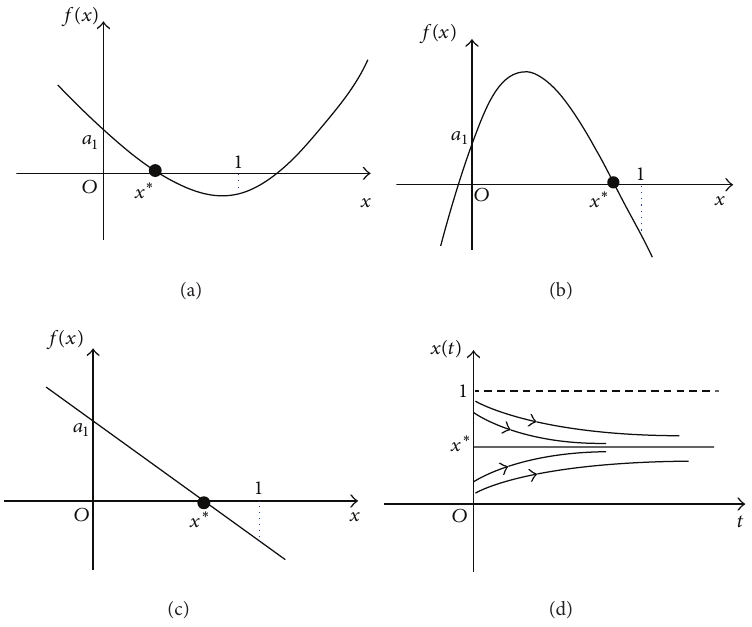
Figure 1: Illustrations of function image of 𝑓(𝑥) = 0 under different cases ((a), (b), and (c)), and the phase diagram (d) of system (6). Here (a) 𝑎 3 > 0 , (b) 𝑎 3 < 0 , and (c) 𝑎 3 = 0